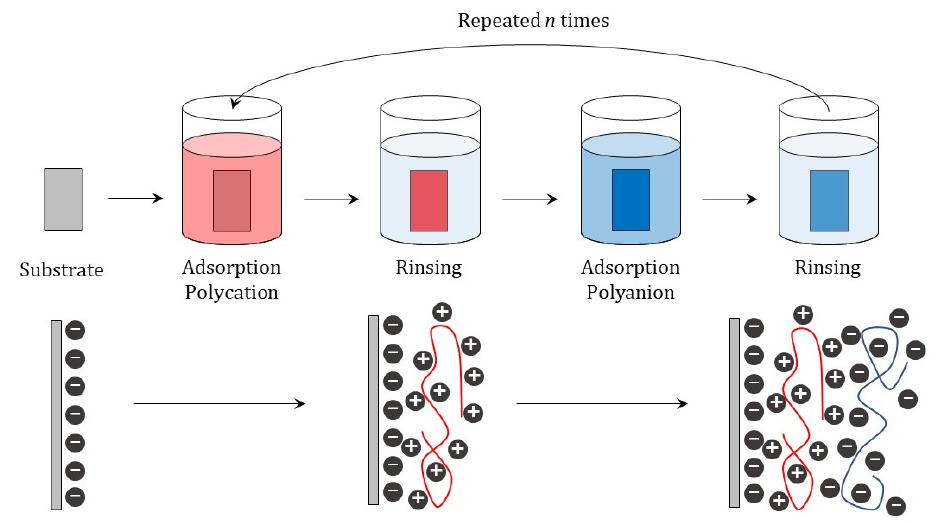
Figure 5. Sketch of the common methodology used for the fabrication of Layer-by-Layer (LbL) multilayers on a flat substrate by deposition for immersion.